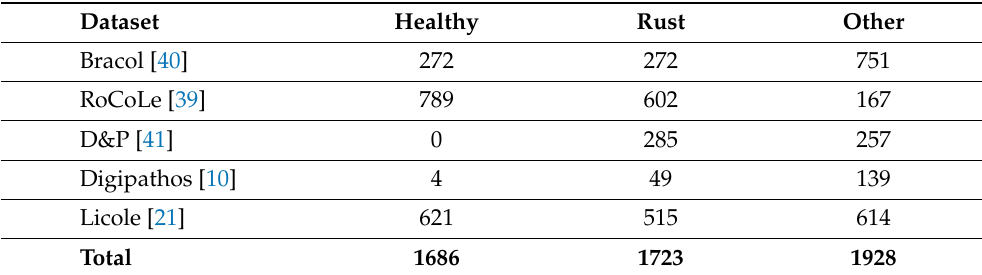
Table 2. Number of images used for coffee leaf rust classification in the present study from state-of- the-art datasets: H (Healthy), R (Rust), and